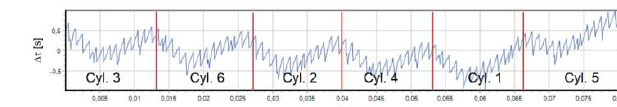
Fig. 10. The chart of time differences as a function of time for the engine with a damaged cylinder no. 1 (measurement of acceleration of the injector carried out on cylinder No. 3)